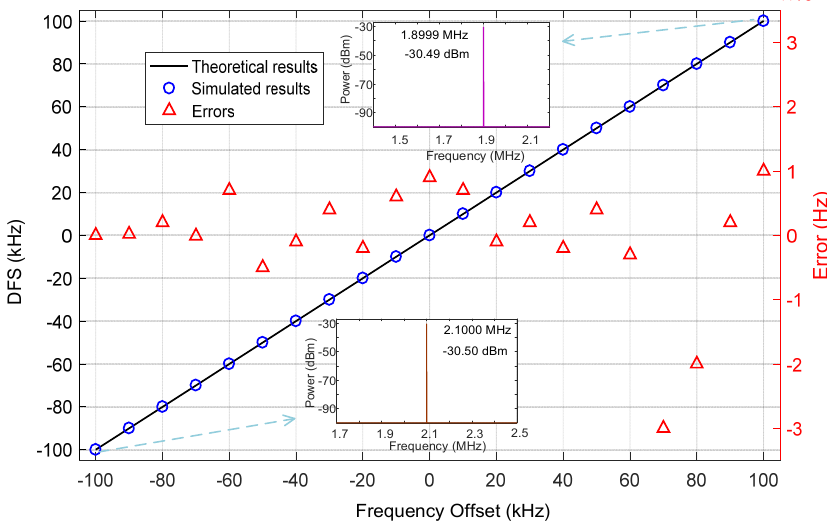
Figure 4. The simulated (dot) and the actual DFS (solid line) results from − 100 kHz to 100 kHz with a step of 10 kHz and the corresponding errors (red triangles). To clearly show the simulated results, the electrical spectra at the DFSs of ± 100 kHz are also shown in the insets of Figure 4 respectively. Subsequently, the echo microwave signal frequency is fixed at 15.001 GHz while a variable phase difference between the two echo signals is adjusted by controlling the phase shifter, and 21 data points are measured in the range from − 180 ◦ to 180 ◦ . The normalized theoretical curve obtained from Equation (10) and measured normalized power of the output electrical signal versus phase difference of the two echo signals are shown in Figure 5. As can be seen, the simulated results match well to the theoretical results except from the notch portion. The reason for a big gap around the notches is that the normalized power is infinitesimal when the power is zero in the theoretical formula, which will cause a very small measurement error to the actual measurement for the slope of the curve is pretty stiff. It is also noted from Figure 5 that the phase difference in the range from − 180 ◦ to 180 ◦ can be accurately estimated from these two curves, for one power value maps two same phase values from the lower branch (blue curve), but it corresponds to two different phase values in the upper branch (red curve). This means the system can realize the unambiguous phase measurement within the 360 ◦ phase range.